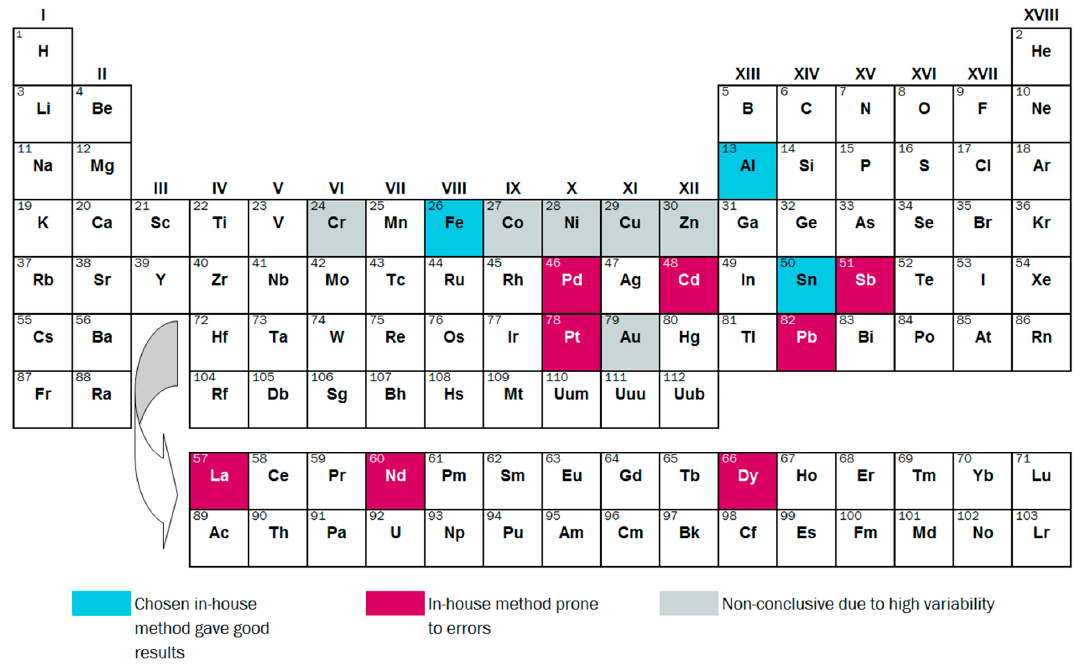
Figure 8. Overview of conclusions regarding the suitability of in-house methods for measuring 17 elements in SLF.